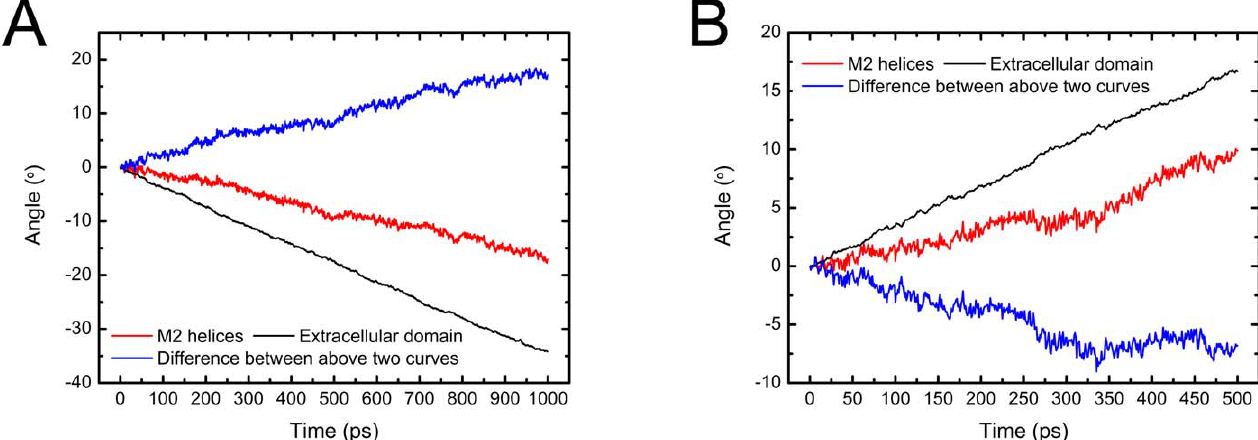
Figure 7. The Time-Dependence of the Rotation Angles of EC Domain and M2 Helices as the Receptor Rotates in Clockwise (A) and Anticlockwise (B) Directions The difference between the rotation angles of EC domain and M2 helices is also shown (blue solid line). doi:10.1371/journal.pcbi.0040019.g007 PLoS Computational Biology |